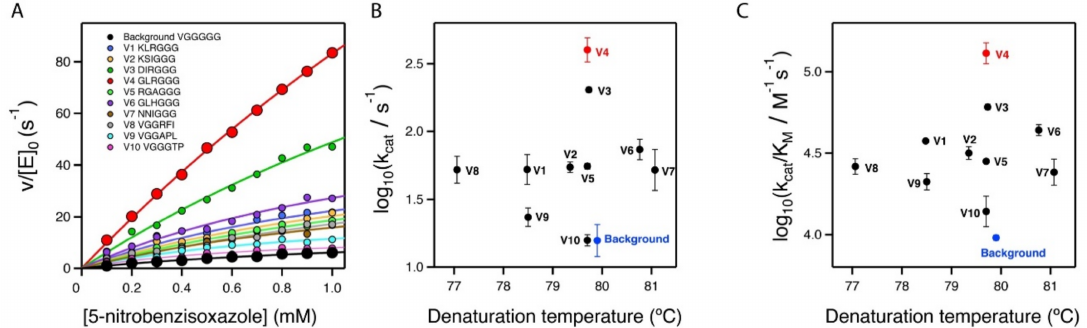
Figure 4. Secondary screening of the top variants from the primary library screening shown in Figure 3. ( A ) Michaelis–Menten profiles for the top variants at pH 7 (profiles for the best variant at pH 8.5 are shown in Figure 2B). The sequences at the relevant section of the included polypeptide are shown. Note that, for all variants, three independent Michaelis–Menten profiles were determined (see Supplementary Table S1 and Supplementary Figure S1); however, for the sake of clarity, only one representative profile for each variant is shown here. ( B , C ) Plots of Michaelis–Menten catalytic pa- rameters for all the variants versus denaturation temperature, as determined by differential scanning calorimetry. These plots are scattergrams, indicating the absence of a significant stability/activity